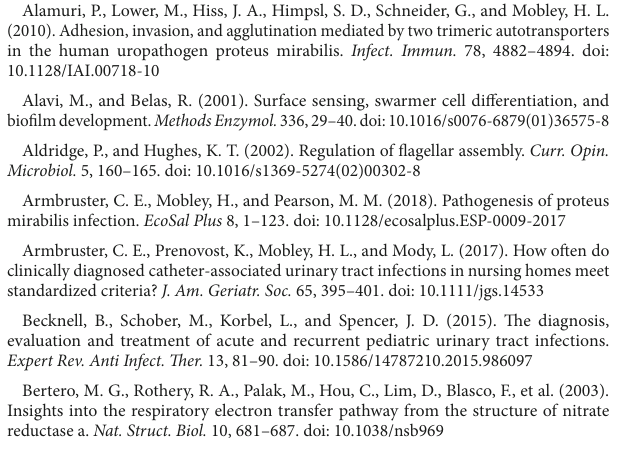
SUPPLEMENTARY FIGURE S1 Flagellar synthesis pathway (Aizawa, 2001; Aldridge and Hughes, 2002;